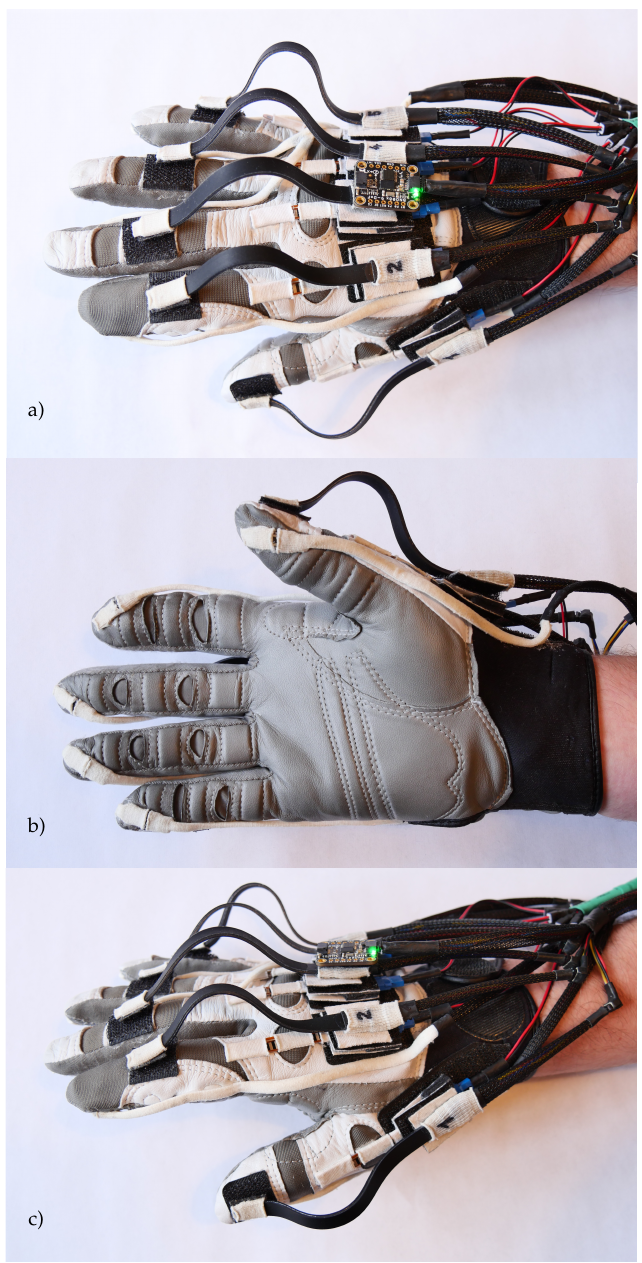
Figure A7. Final realization of SenGlove for a medium-sized right hand with all five fingers equipped with sensors. ( a ) Dorsal view. ( b ) Palmar view. ( c ) Lateral